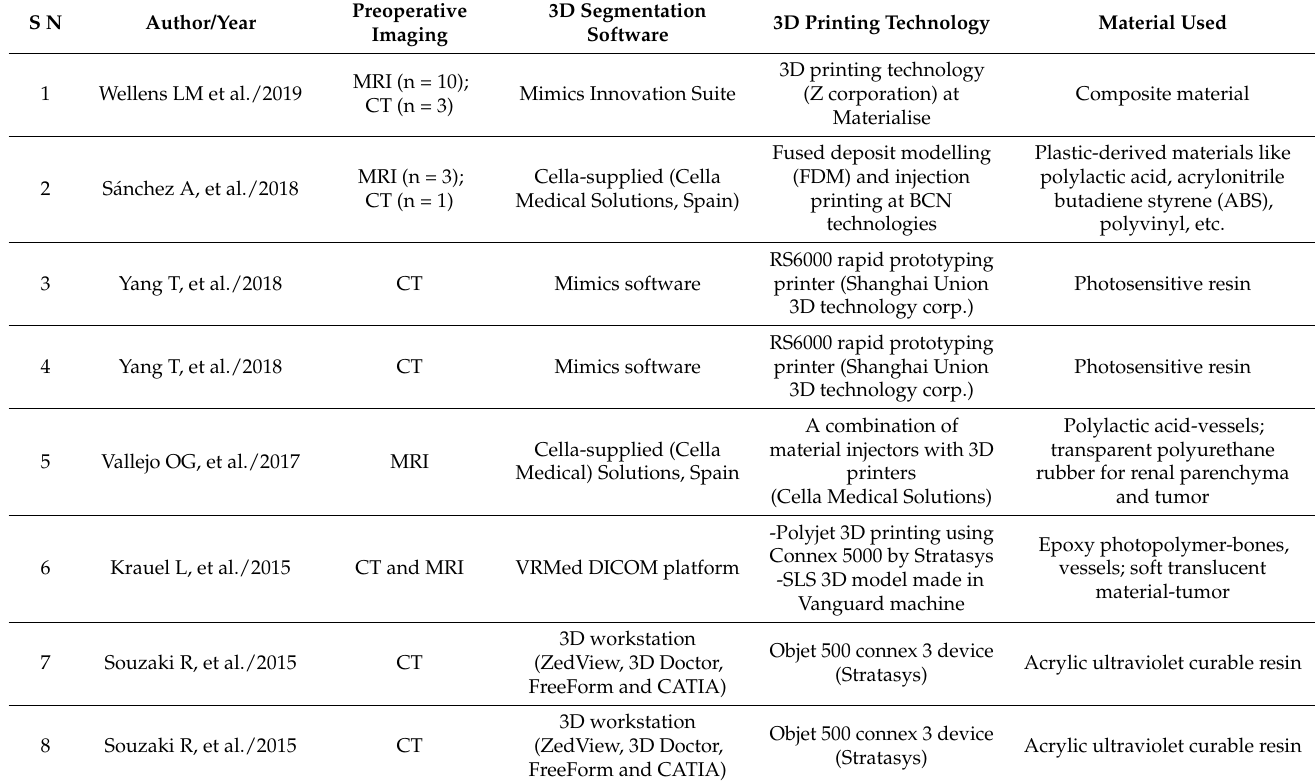
Table 2. Details of imaging and 3D printing.